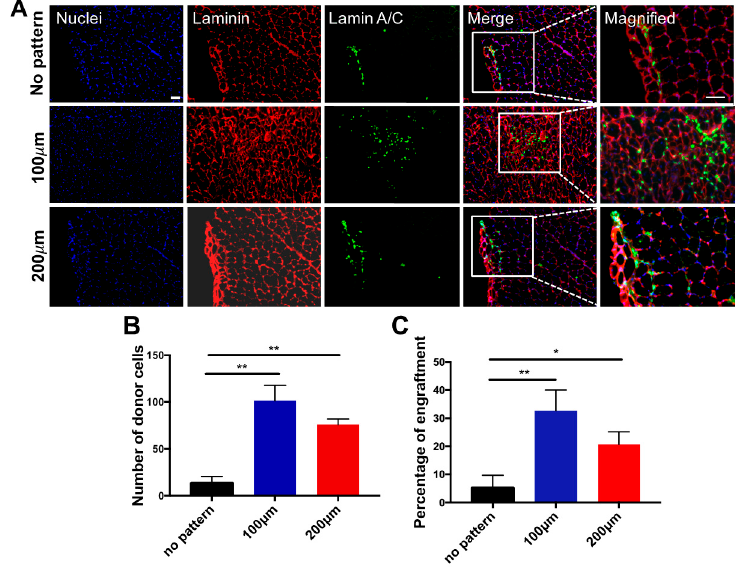
Figure 6. Engraftment of myogenic progenitor cells in cardiotoxin-injured mice. ( A ) Immunofluorescence staining of TA muscle of NOD/SCID mice transplanted with cells cultured on non-patterned substrates (top row), 100 µ m-width grooves (middle row) and 200 µ m-width grooves (bottom row) for 21 days of in vitro differentiation prior to the transplantation. Muscle sections were stained for mouse laminin (red), anti-human lamin A/C (green) and nuclei (blue). Scale bar = 50 µ m; ( B ) Estimated number of total donor nuclei; ( C ) Estimated percentage of fused donor cells 14 days post-transplantation. * p < 0.05 and ** p < 0.01.